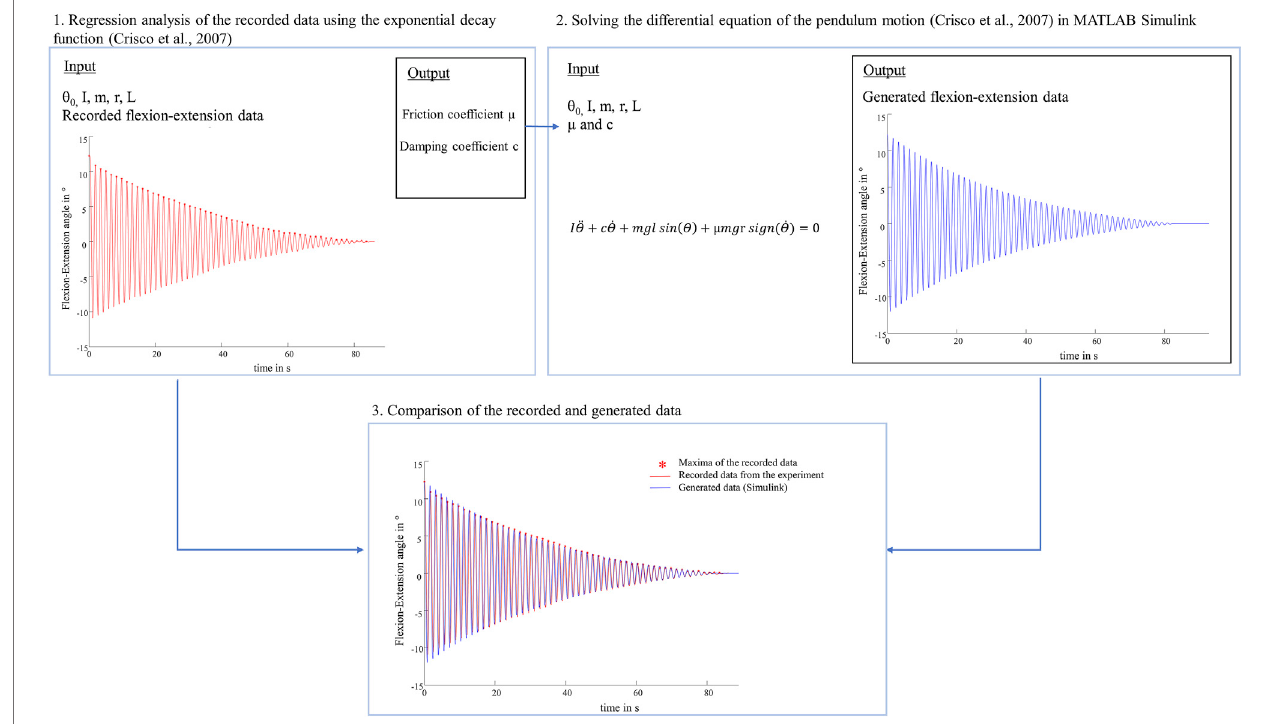
FIGURE10| Schematicrepresentationoftheperformedidenti fi cationprocedure.1.Theviscousdampingcoef fi cient(c)andtheviscousfrictioncoef fi cient(µ)were determined by nonlinear curve- fi tting of the exponential decay function (Crisco et al., 2007) as described in the materials and methods section. 2. Following, the differential equation of the physical pendulum motion (Crisco et al., 2007) was solved with the same input values (initial de fl ection ( θ 0 ), moment of inertia (I), pendulum mass (m), radius of the femoral condyle (r), distance between the pendulum center of mass and the rotation axis (L)) and the determined values for the friction coef fi cient (µ) and damping coef fi cient (c) using MATLAB Simulink. 3. The comparison of the recorded fl exion-extension motion (red) and the generated oscillation (blue) indicated very similar oscillation data over